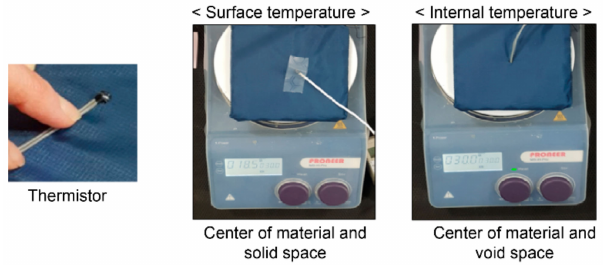
Figure 4. Temperature measurement of a technical material.